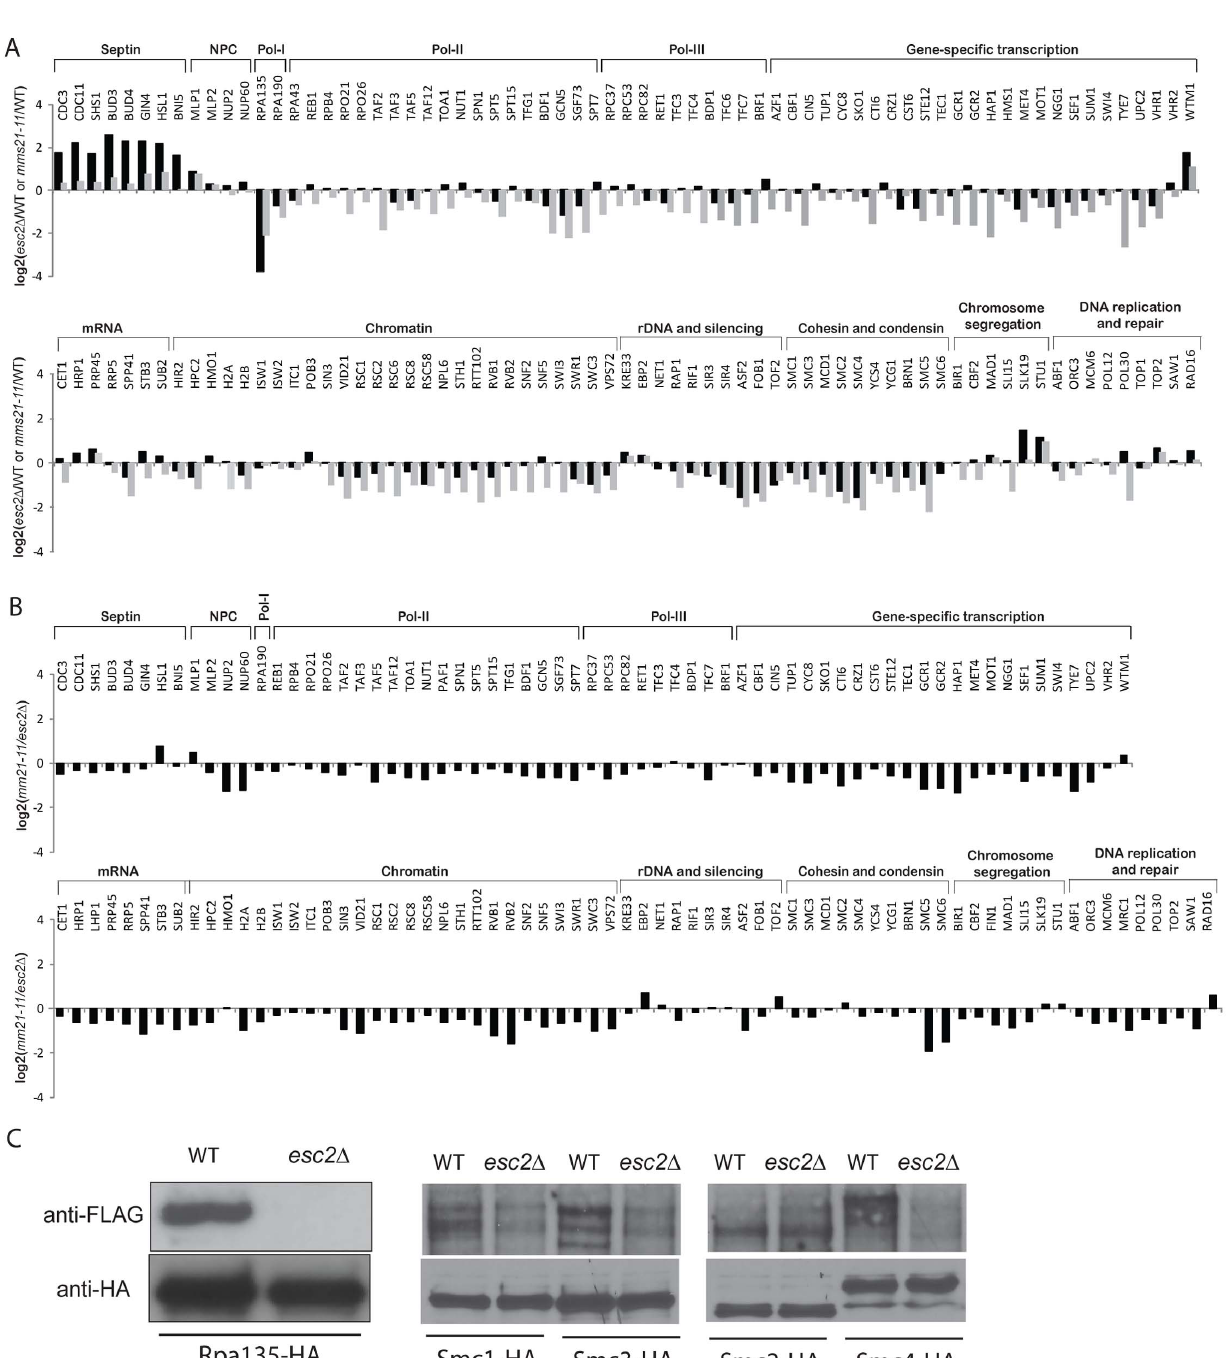
Figure 4. Effect of esc2 D on the sumoylation of SUMO targets. A) Bar graph shows the relative abundance of SUMO targets between esc2 D and wild-type cells (black bars). As a comparison, the results of mms21-11 versus wild-type cells are shown in grey bars. B) Quantification of the relative abundance of SUMO targets between esc2 D and mms21-11 mutants. C) Western blot analysis of the effect of esc2 D on the sumoylation of SMC proteins and Rpa135. Each SUMO target was purified by anti-HA antibody and probed for its sumoylation by anti-FLAG Western